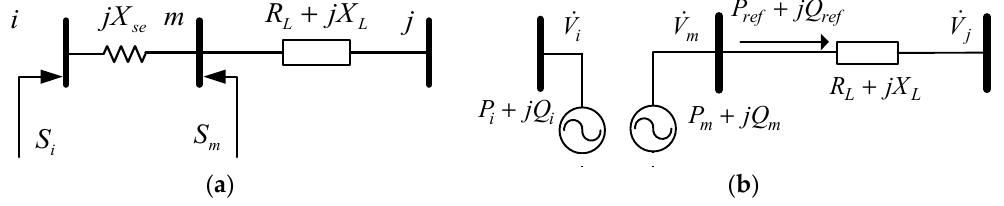
Figure 2. The power flow calculation model of UPFC: ( a ) power injection model of UPFC; ( b ) additional node model of UPFC.